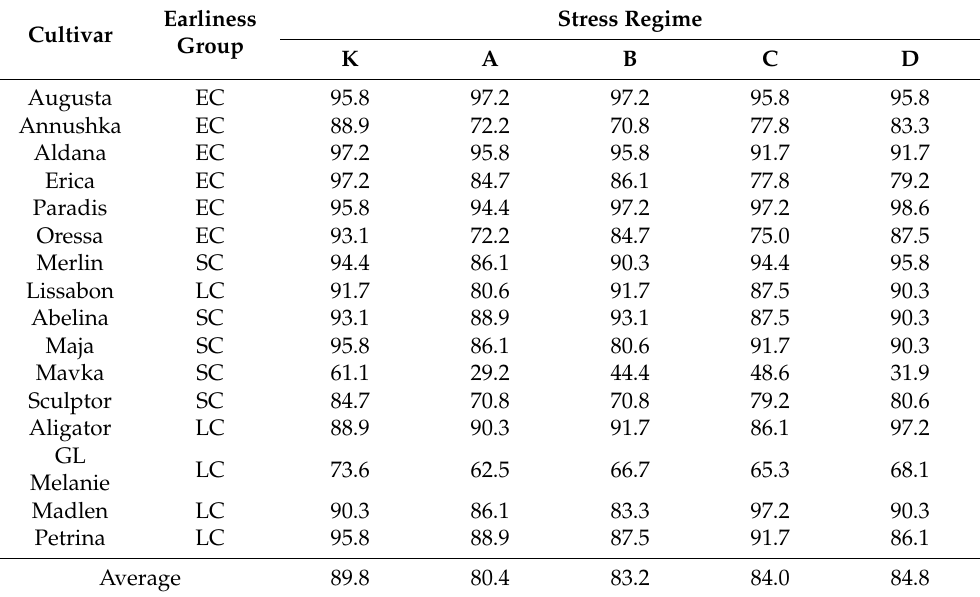
Table 2. Seedling emergence (%) after 21 days depending on stress regime and cultivar (n =